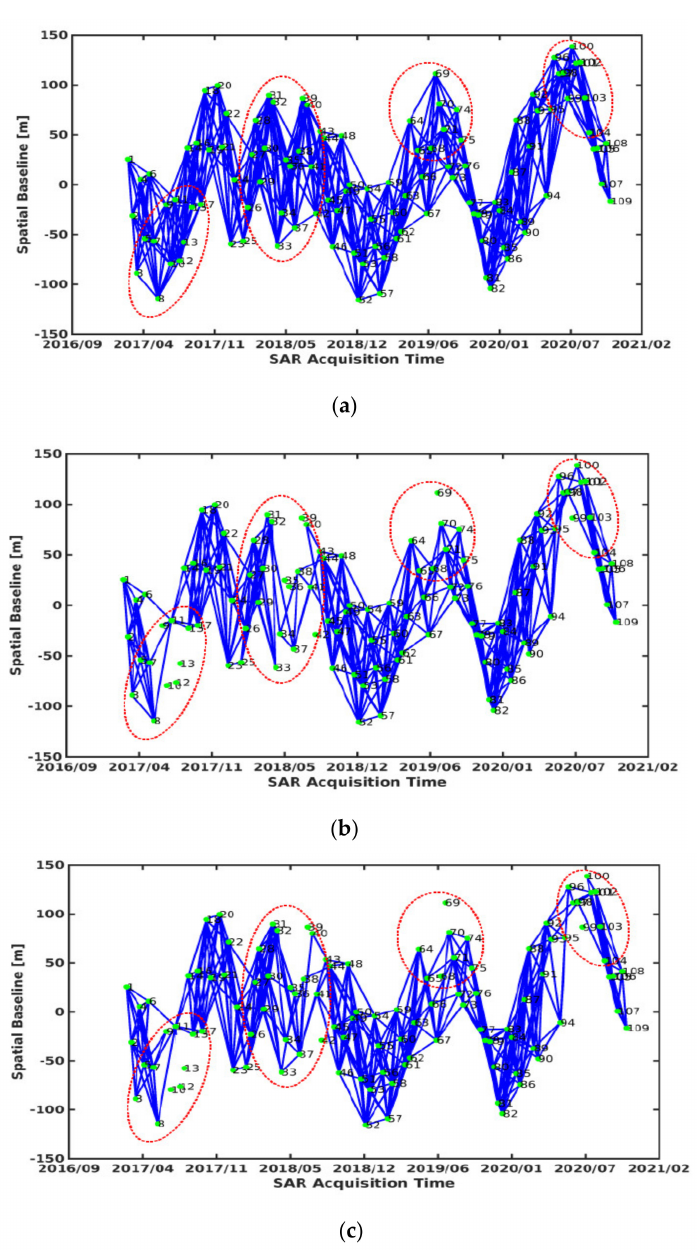
Figure 10. Interferograms selected by ( a ) the spatio-temporal baseline threshold method, ( b ) the manual method and ( c ) the ResNet50–DCNN model